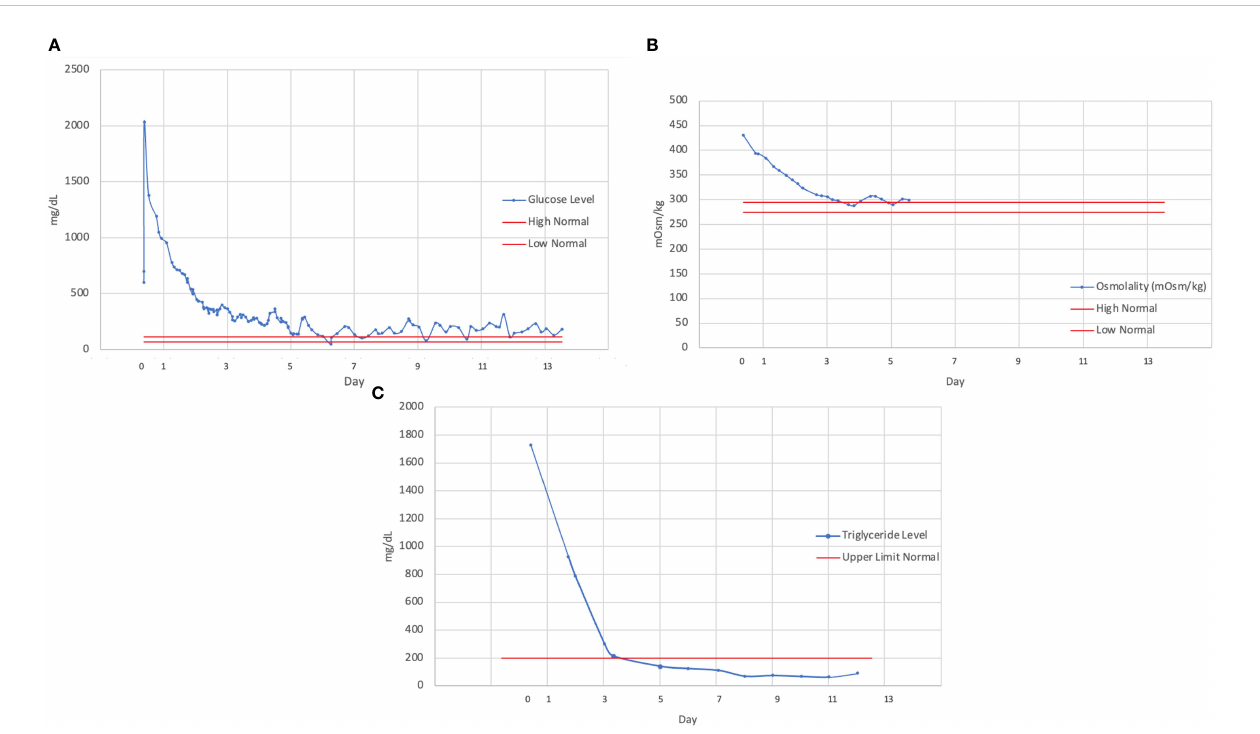
FIGURE 1 Trend of (A) serum glucose, (B) osmolality, (C) and triglyceride levels over the course of hospitalization, demonstrating a slow rate of correction over several days. Continuous intravenous insulin was discontinued on hospital day 5 (beginning with day of admission as day